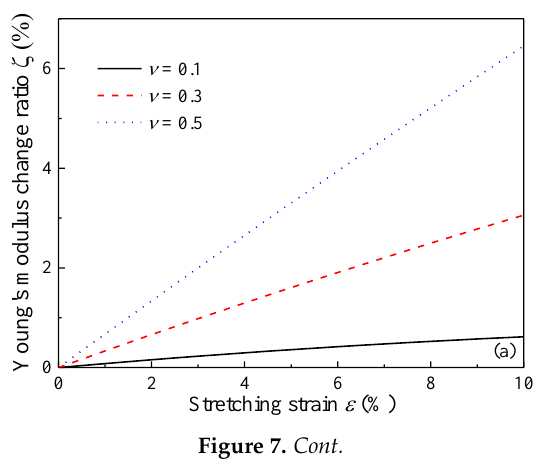
Figure 6. Young’s modulus change ratio of GPL/Epoxy nanocomposites ( a ) stretching direction; ( b ) transverse direction.